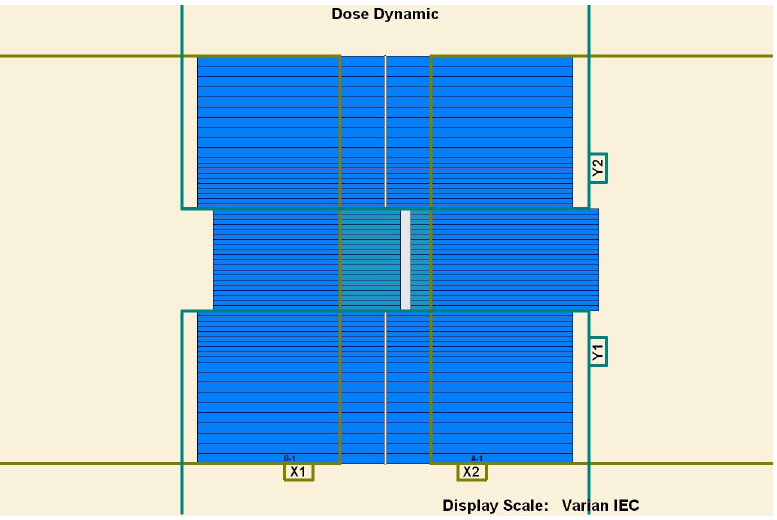
Fig 4. Five segments designed to be 1 × 10 cm 2 . (1) First segment’s center: − 4 cm. (2) Second segment’s center: − 2 cm. (3) Third segment’s center: 0 cm. (4) Fourth segment’s center: 2 cm. (5) Fifth segment’s center: 4 cm.